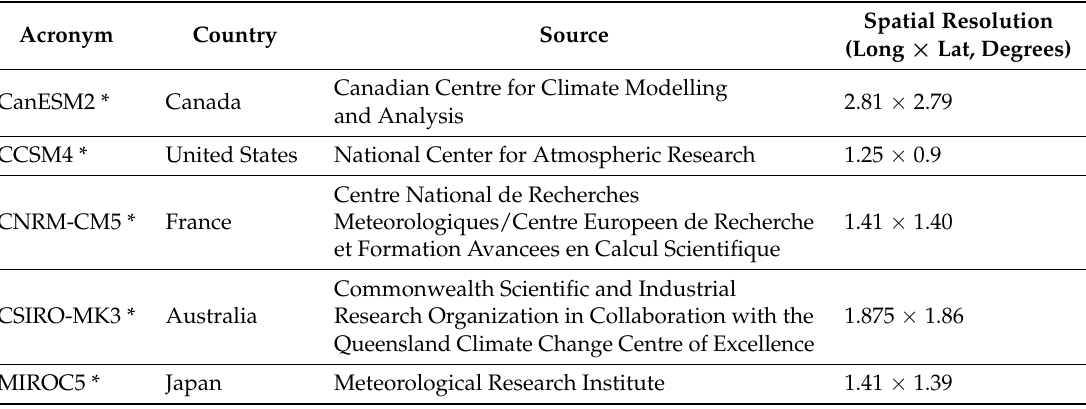
Table 1. General information of selected General Circulation Models (GCMs) and scenarios available from the Pacific Climate Impacts Consortium (PCIC)